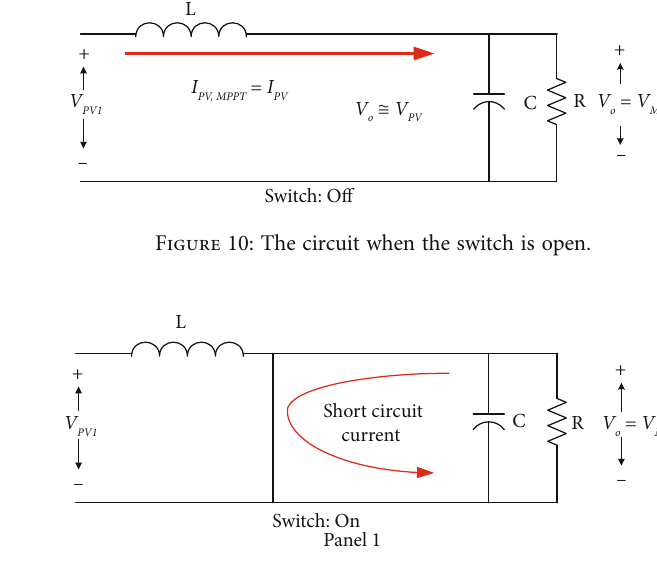
Figure 11: The circuit when the switch is open.